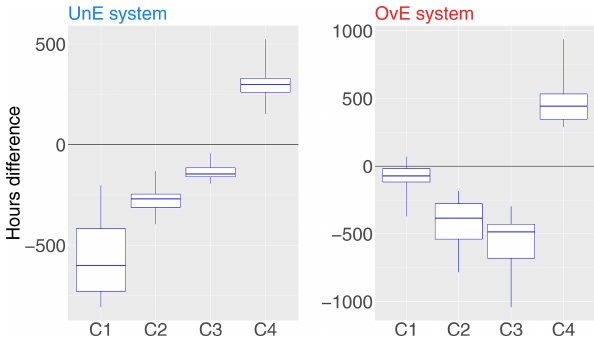
Figure 11. Differences in production hours between the reference system (i.e., the “perfect system”, where forecasts are equal to ob- servations) and two synthetic ensemble forecasting systems: under- estimating system (UnE, blue) and overestimating system (OvE, red). Differences are pooled into four classes of production rate (from lower C1 to higher C4 production rate). Synthetic systems are based on ensembles generated with spread factors of 4%. Box- plots represent the maximum value, percentiles 75, 50 and 25, and minimum value over the 10 studied catchments.